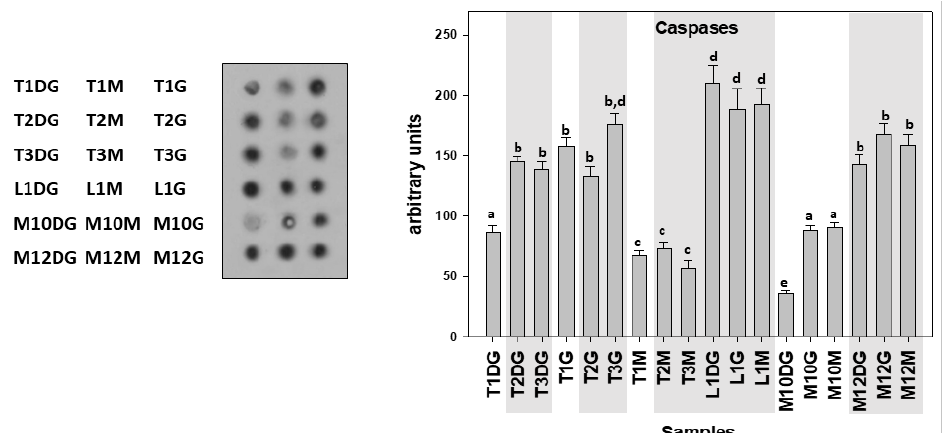
Figure 7. Cleaved caspases levels in the digestive gland (DG), gills (G), and mantle (M) of Pinna nobilis specimens from the Kalloni Gulf (Lesvos Island) (M10, M12), from the Thermaikos Gulf (Thessaloniki) (T01, T02, T03), and from Limnos Island (L1). All specimens were infected with mycobacterium and vibrio, while grey shaded areas represent specimens additionally infected with the haplosporidian parasite. Tissue extracts from all groups were immunoblotted for caspases. Dots were quantified using scanning densitometry. Representative dots are shown. Lower-case letters indicate statistically significant differences ( p < 0.05) between samples.